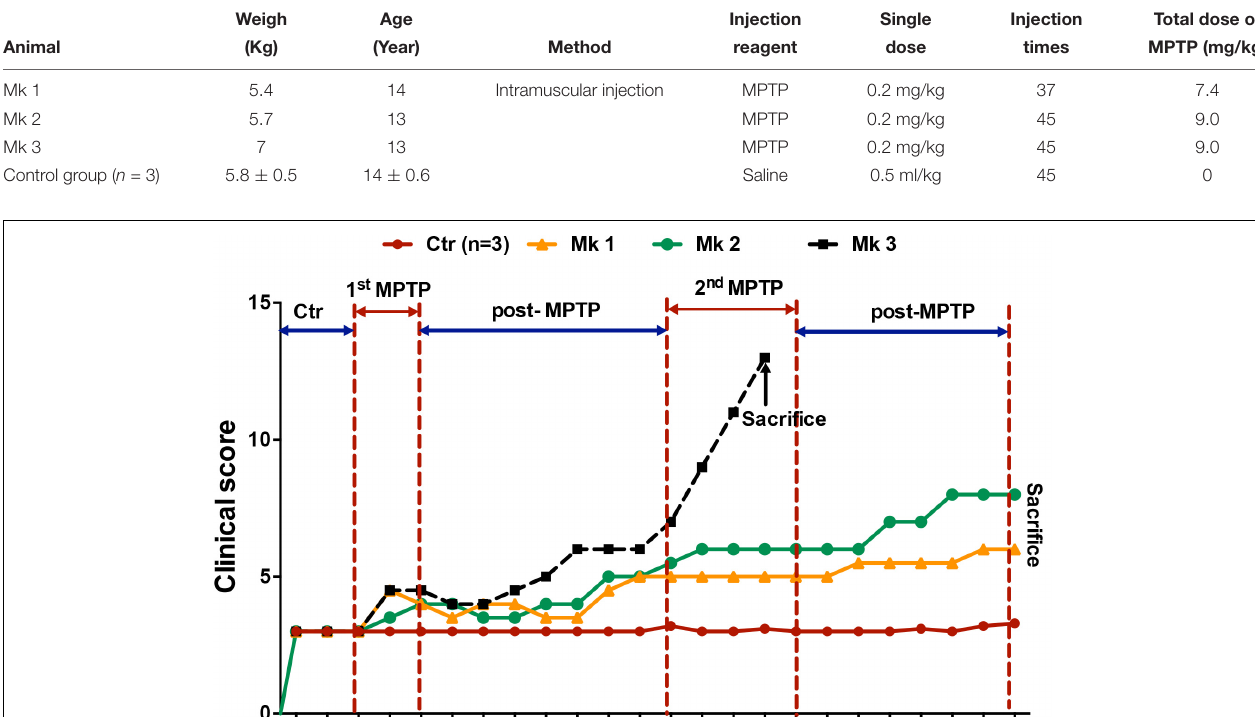
TABLE 1 | Information of animals and MPTP treatment.